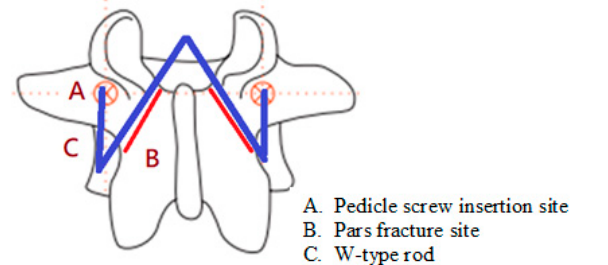
Figure 1. Bilateral pars fractures with pedicle screw W-type rod fixation. Note: red line indicates the fracture site; and blue line indicates the shape of the W-type rod.